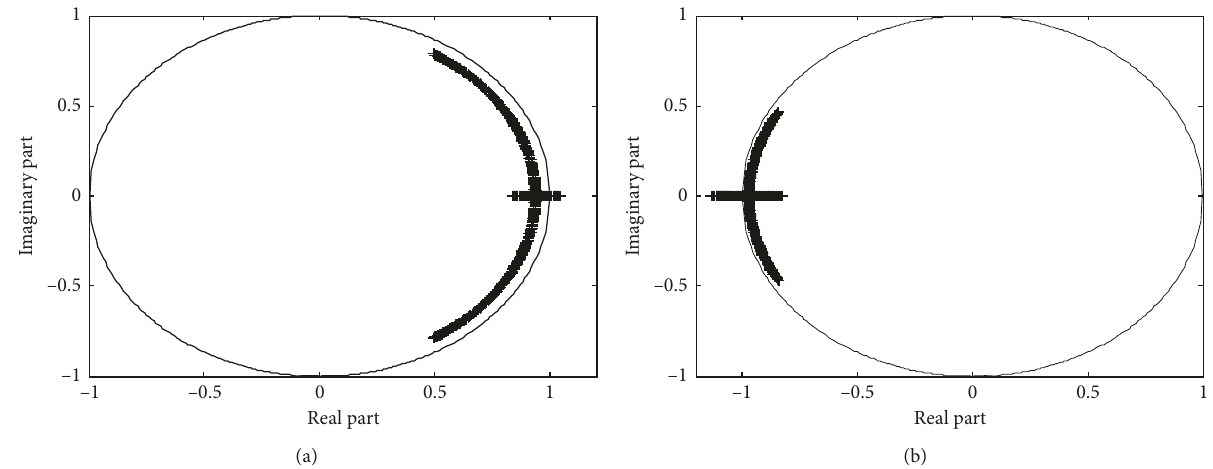
Figure 10: Floquet multipliers with r changing from 0 to 0.5 for (a) 4000rpm–4600rpm (period doubling) and (b) 8000rpm–9100rpm (saddle-node).